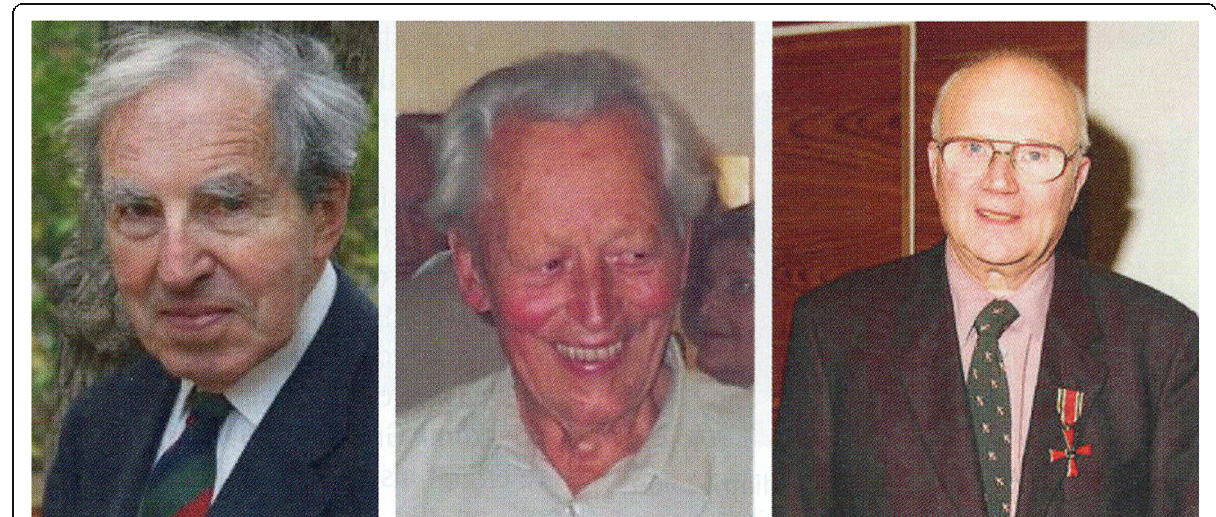
Fig. 2 a , b and c Dieter Janz, Ansgar Matthes, and Rolf Kruse, precursors of neuropediatrics in